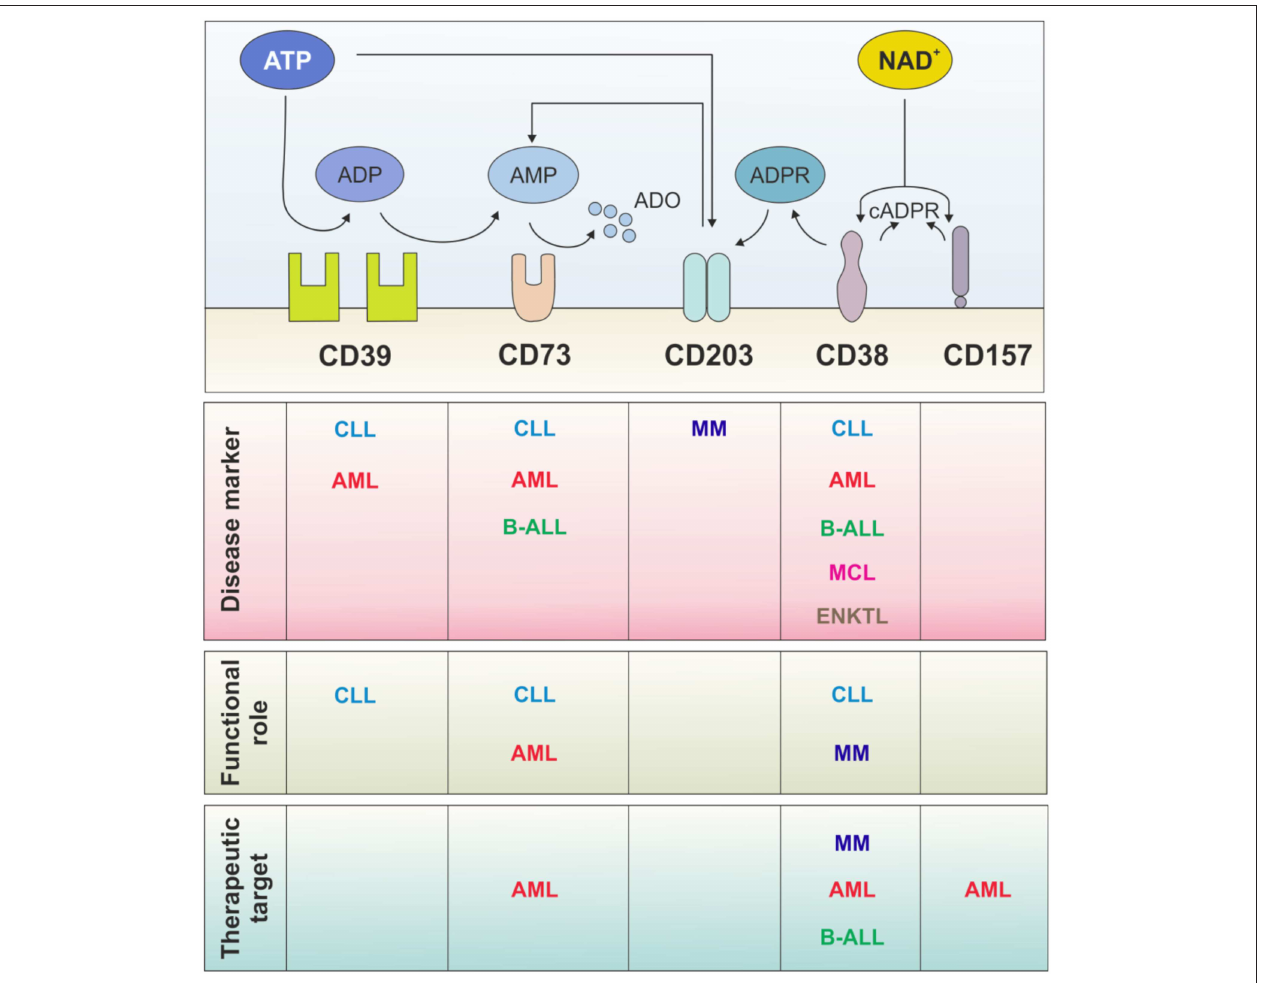
FIGURE 2 | Multiple roles of ectonucleotidases in hematological malignancies. Surface NAD + - and ATP-dismantling enzymes have been widely exploited as disease markers for patient stratification and with prognostic relevance. In contrast, few studies, mainly in CLL and AML, address their functional role in the disease biology. Independently of their role, they may represent therapeutic targets: CD38 is a leading example with monoclonal antibodies already in the clinical practice. Several strategies have been designed to target ATP-dismantling enzymes, mainly in solid tumors, and conceivably should be exploited in hematological malignancies in the near future. CLL, chronic lymphocytic leukemia; MCL, mantle-cell lymphoma; B-ALL, B-acute lymphoblastic leukemia; AML, acute myeloid leukemia; ENKTL; extranodal natural killer/T cell lymphoma; MM, multiple